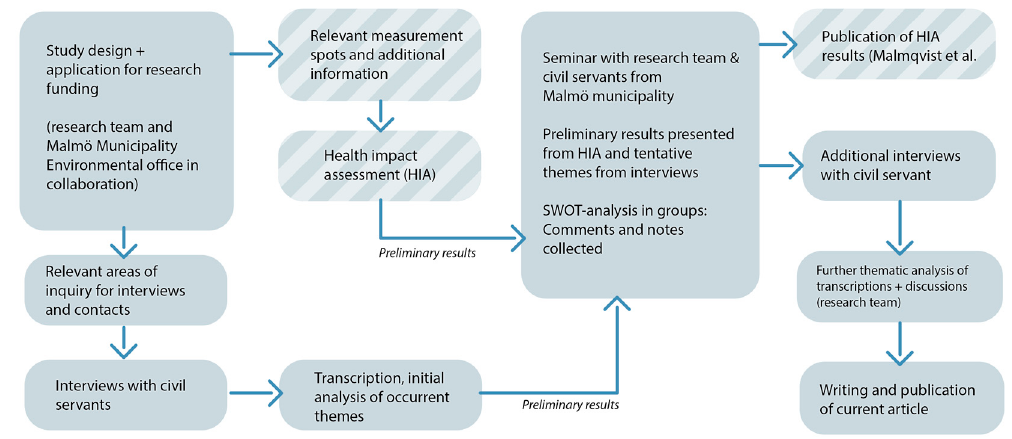
Figure 2. Flowchart of collaborative and transdisciplinary research project Air Pollution Research in Local Environmental Planning (ARIEL), from the design of quantitative and qualitative strands of research via studies and feedback seminars to publications.